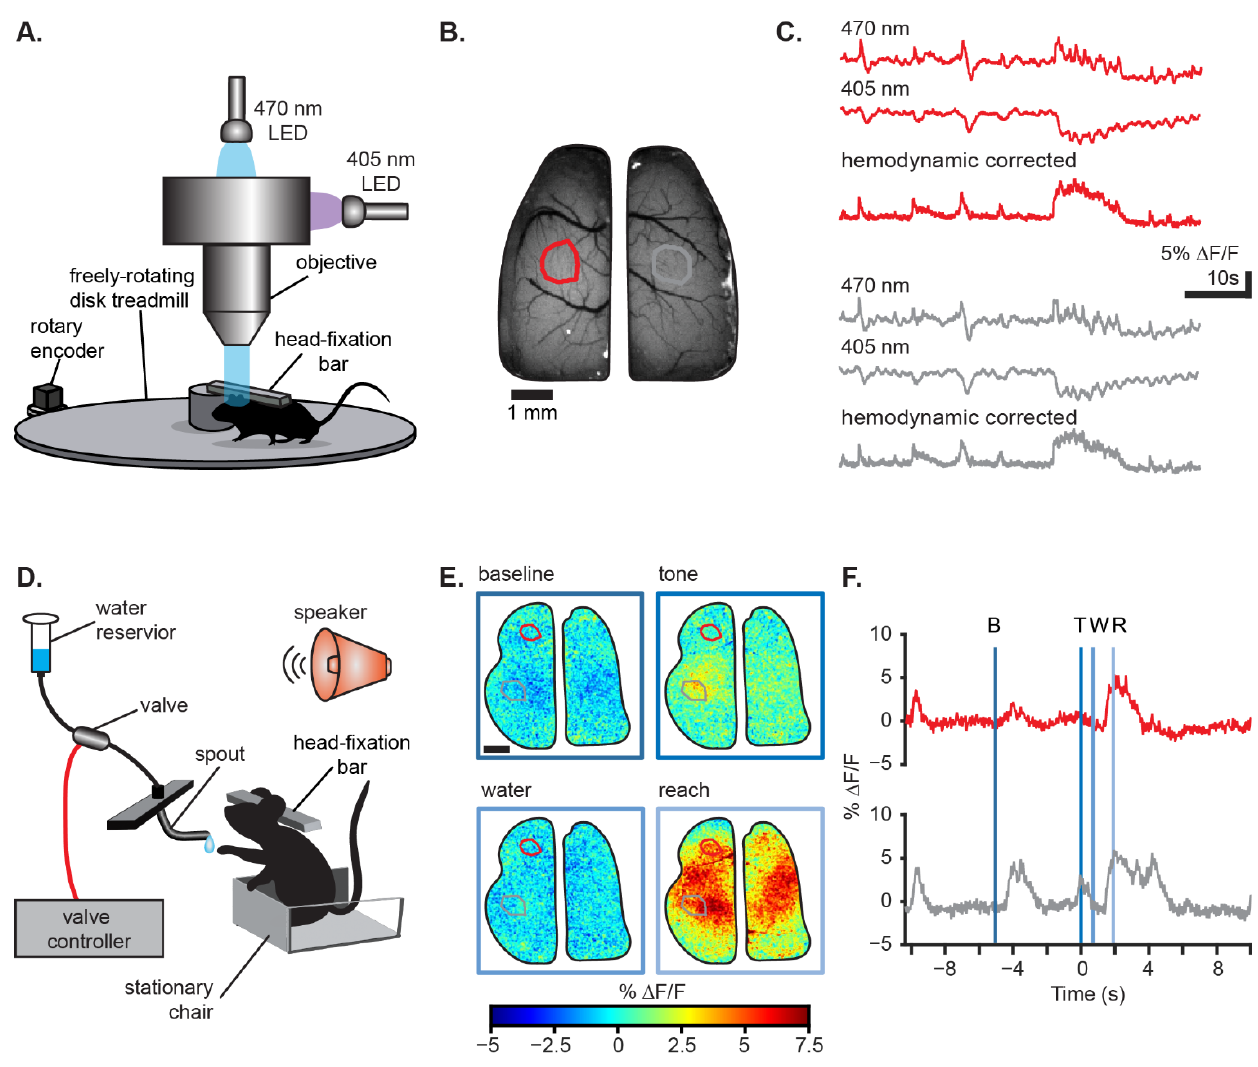
Figure 1. Wide-field Ca 2+ imaging allows for investigation of neural processing during multiple behavioral paradigms. ( A ) Schematic showing an example of a wide-field imaging setup allowing for head-fixed behavior on a disk treadmill. ( B ) Example image showing the extent of the imaging field with non-brain regions masked in white. Scale bar 1 mm. ( C ) Example Ca 2+ traces from ROIs (red and grey circles) in ( B ) during an imaging session on the disk treadmill setup in ( A ). Ca 2+ traces shown are raw Ca 2+ -dependent GCaMP6f signals (470 nm; top), Ca 2+ -independent GCaMP6f signals (405 nm; middle), and hemodynamic corrected GCaMP6f signals (bottom). ( D ) Schematic showing an example of a wide-field imaging setup used for a cued reaching task. ( E ) Pseudo-colored images showing the change in hemodynamic corrected GCaMP6f fluorescence across the cortex during various stages of a cued reaching task. Scale bar: 1 mm. ( F ) Hemodynamic corrected Ca 2+ traces for the ROIs (red and grey circles) shown in ( E ). Traces are centered with the auditory tone cue at time = 0. Blue lines denote the different stages of the reaching task matching the images in ( E ). B = baseline; T = tone; W = water delivery; R = reach.